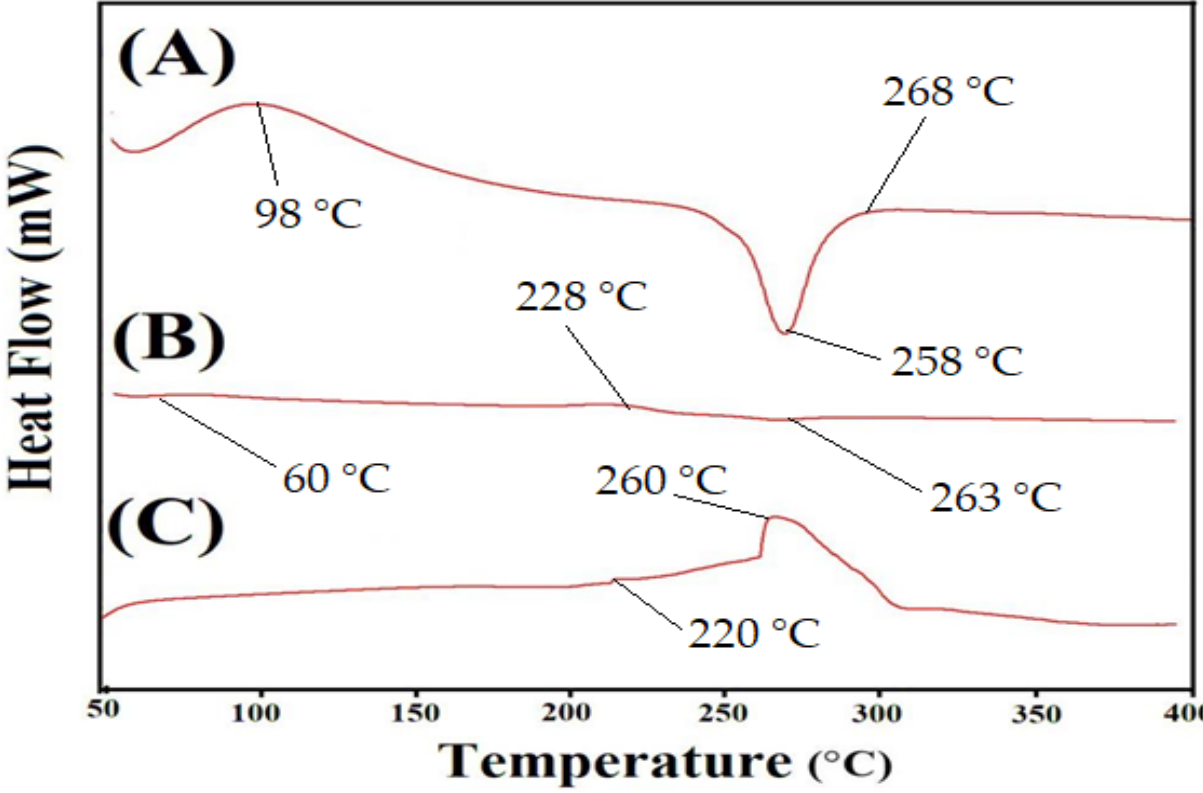
Figure 4. DSC of ( A ) CP, ( B ) Al, and ( C ) CS/Al- g -pAa hydrogel. Figure 4. DSC of (A) CP, (B) Al, and (C) CS/Al-g-pAa